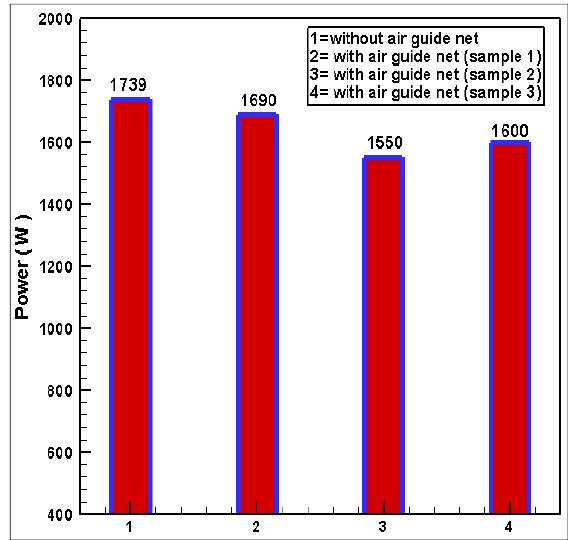
Fig. 9. Graphical representation of the power requirement in the compressor.